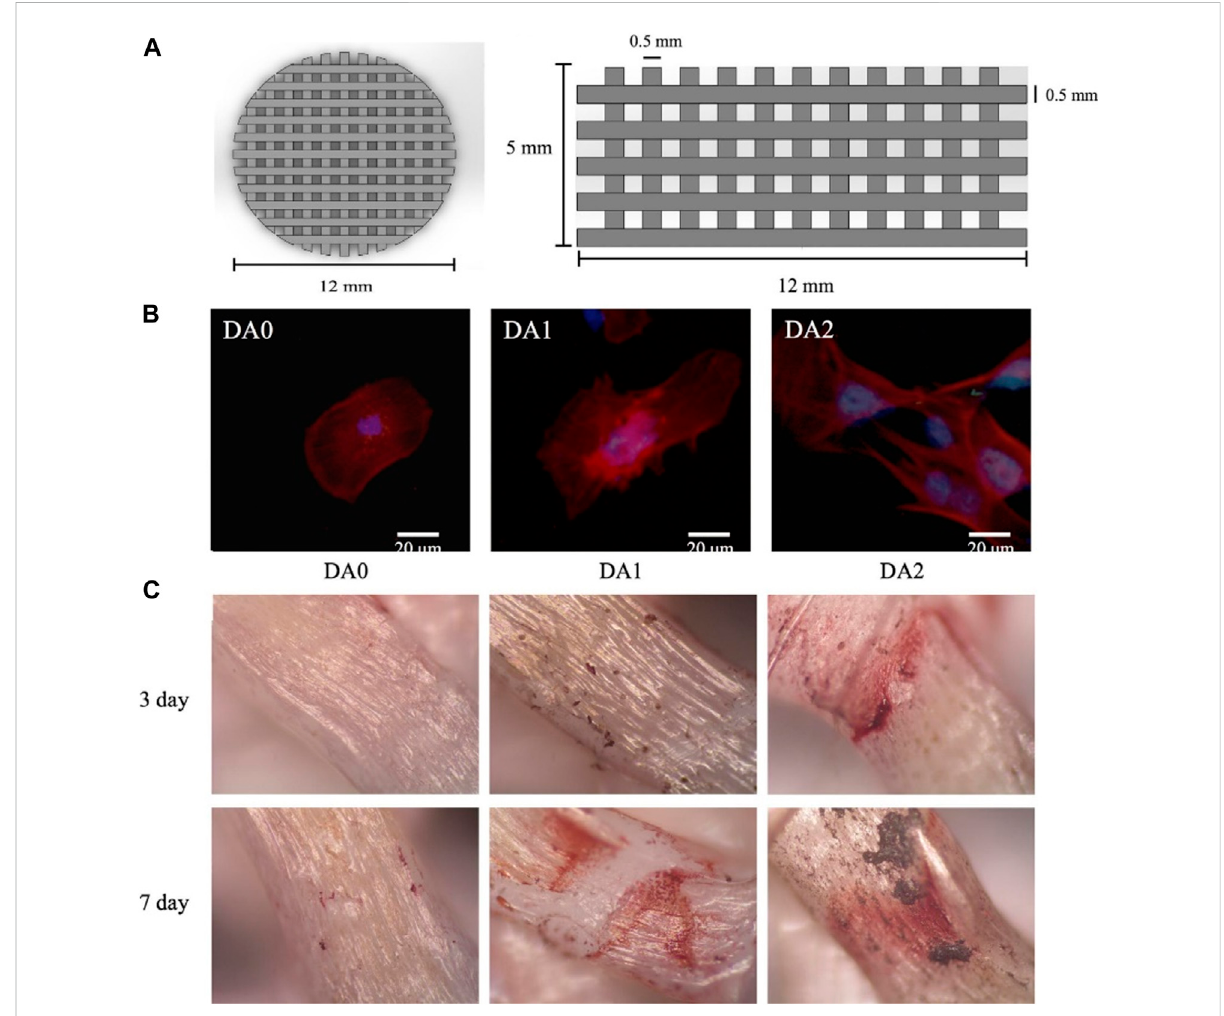
3D-PrintedPLAscaffold coatedwithdopamineforbonetissueengineering(Kaoetal.,2015). (A) Overallappearanceof3DprintedPLAscaffold. (B) Immuno fl uorescence images of hADSCs cultured on 3D printed PDA/PLA scaffolds. (C) Alizarin red staining images of hDPCs cultured on